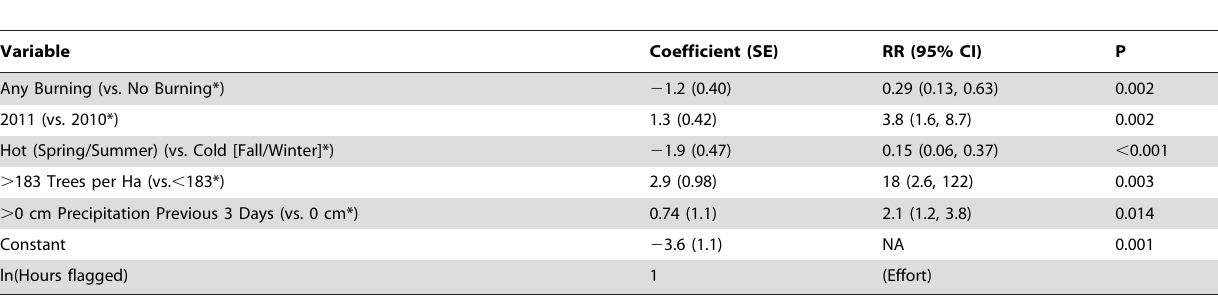
Table 5. Generalized estimating equation negative binomial regression model for the prediction of I. scapularis counts at all 21 plots in 2010 and